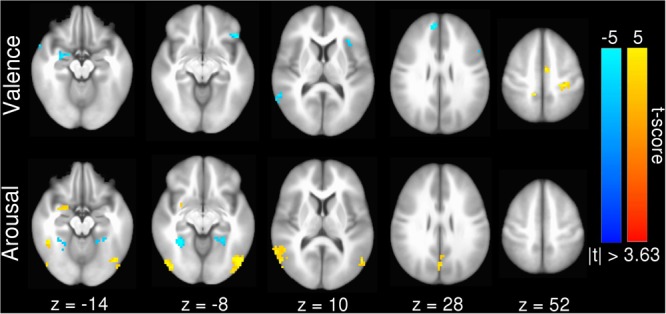
Group statistical map for univariate GLM contrasts of (top) valence (Vpos – Vneg) and (bottom) arousal (Ahigh – Alow), whole-brain masked. Warm (yellow) colors indicate regions where Vpos > Vneg or Ahigh > Alow. Cool (blue) colors indicate regions where Vneg > Vpoa or Alow > Ahigh. Slices are rendered in axial view using Talairach coordinates and neurological convention (image left = participant left).